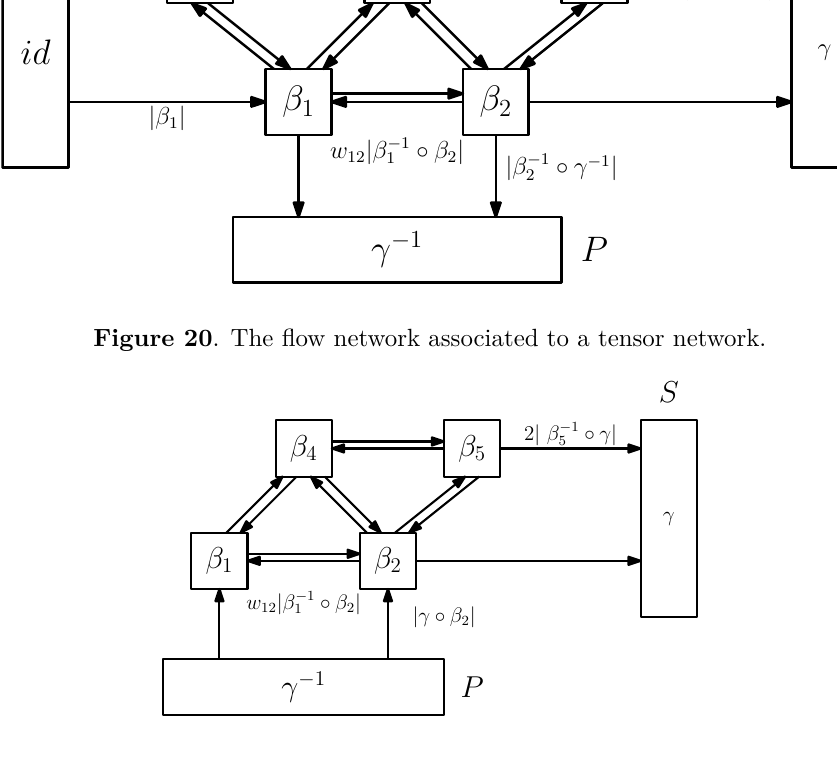
Figure 21 . The flow network for the second